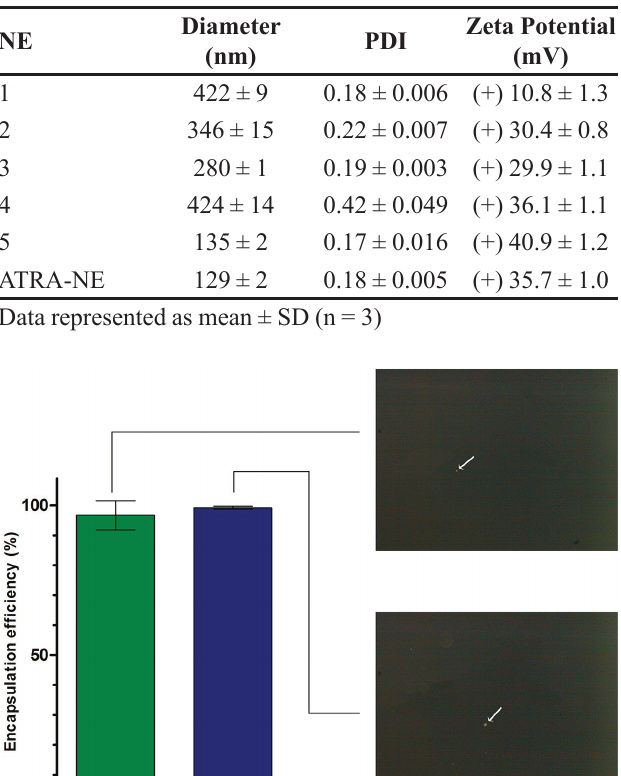
TABLE II – Physicochemical characterization of NE formulations